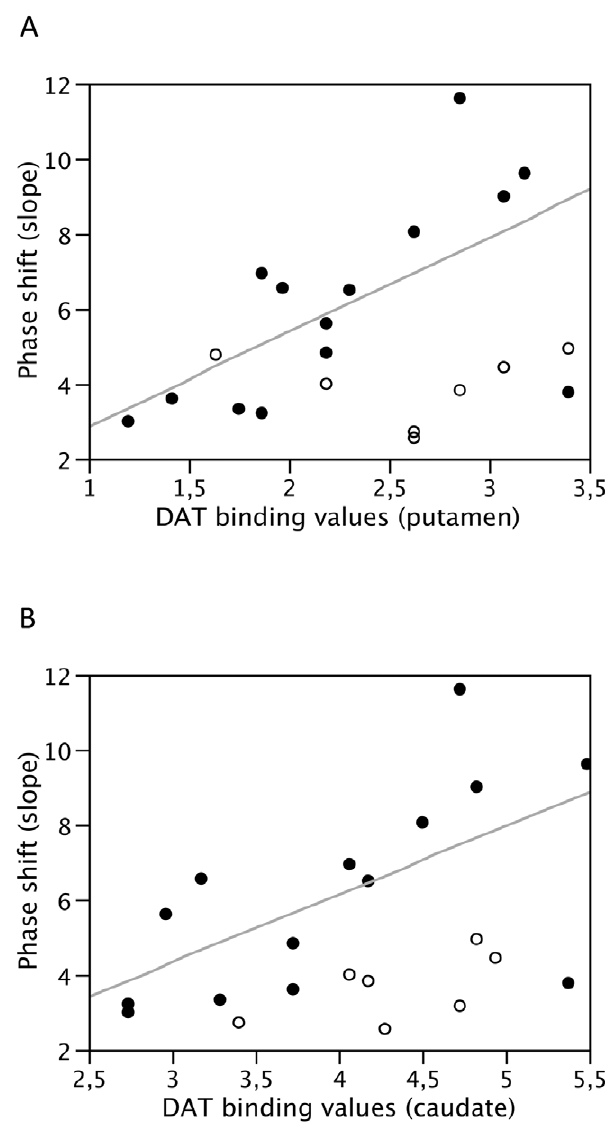
Figure 2. Correlation between phase shift modulation at different gait velocities and DAT binding values of the putamen (A) and caudate nucleus (B). Full dots represent arms with reduced ( , 18 u ) ROM when walking at preferred gait speed. Empty dots shows arms with arm ROM within the normal range. When arm ROM was reduced, a positive correlation was found between upper- lower limb phase shift modulation and both DAT binding values of putamen (RSquare = 0.37, p = 0.01) and caudate nucleus (RSquare=0.38, p=0.01). Correlation lines for arms with normal ROM ( . 18 u ) are not